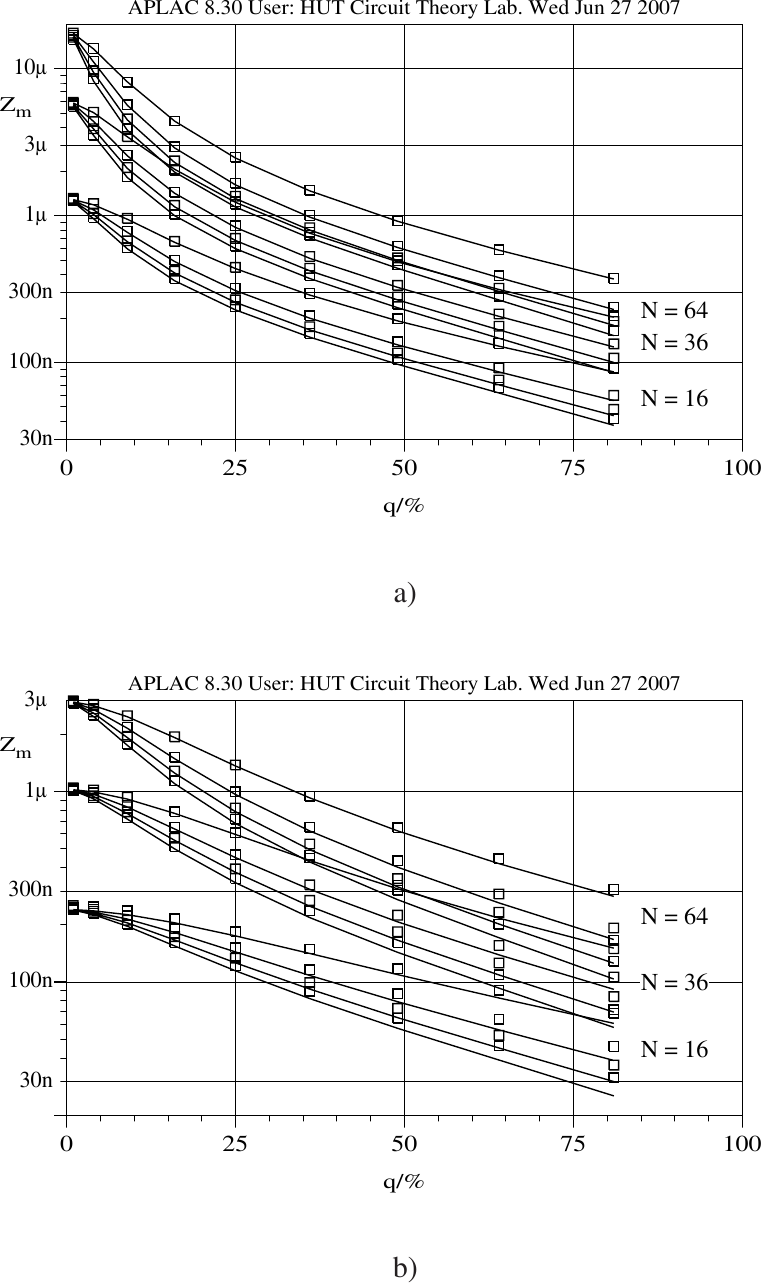
Figure 5 . Damping coef fi cients of the perforated dampers in translational motion simulated with the full 3D N-S solver ( ) and with the PPR solver (——) as a function of the perforation ratio. N is 16 , 36 , (cid:0) and 64 , and the damper height h is 0.5 µ m, 1 µ m, 2 µ m, and 5 µ m. The air gap height is a) 1 µ m and b) c 2 µ